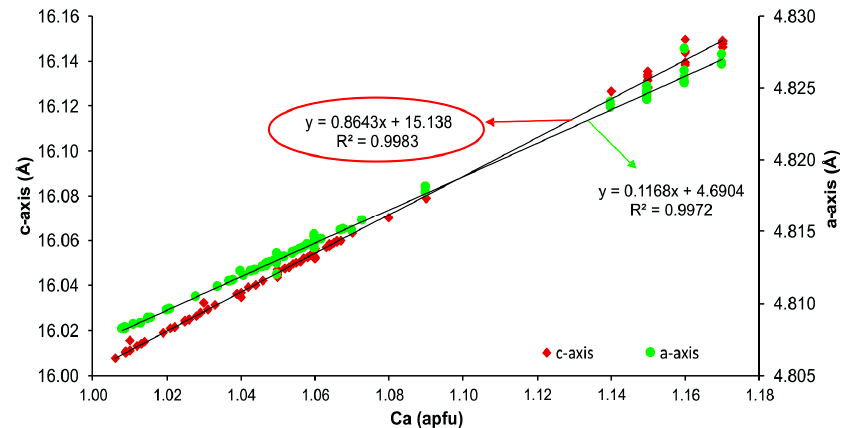
Figure 2. Relationship between the crystallographic axis a and c of Ca amount ( n Ca), evidencing two groups of dolomite, modified from [39].